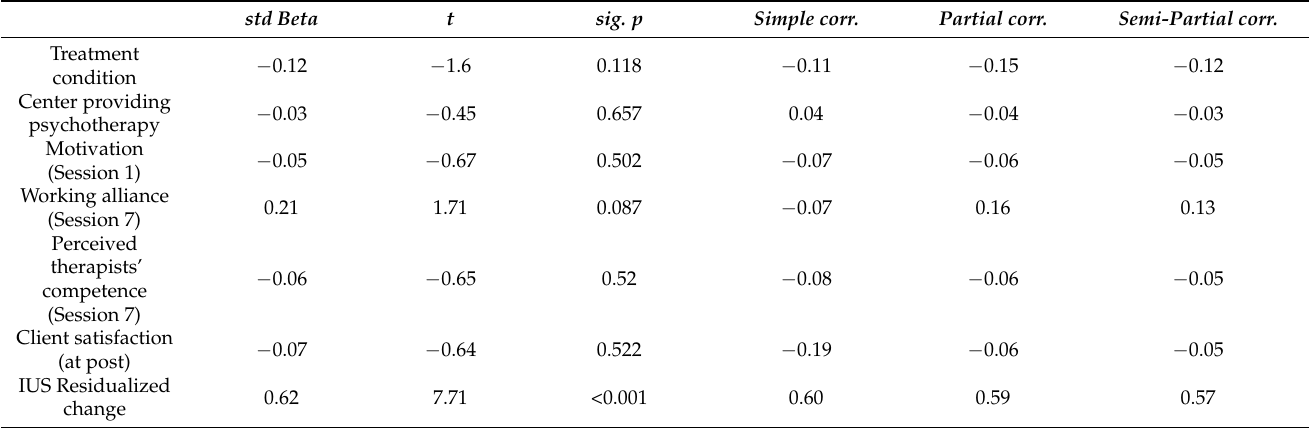
Table 5. Contribution of non-specific and specific factors of CBT for GAD when delivered by video- conference or face-to-face at the second step of a hierarchical regression predicting improvements in ADIS-IV ratings. std Beta t sig. p Simple corr. Partial corr. Semi-Partial corr.